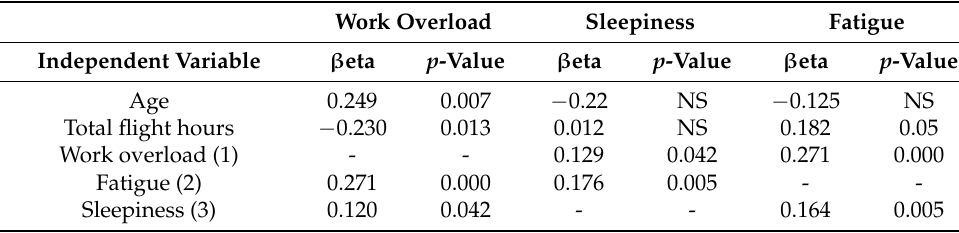
Table 2. Association model between fatigue, work overload, and sleepiness.